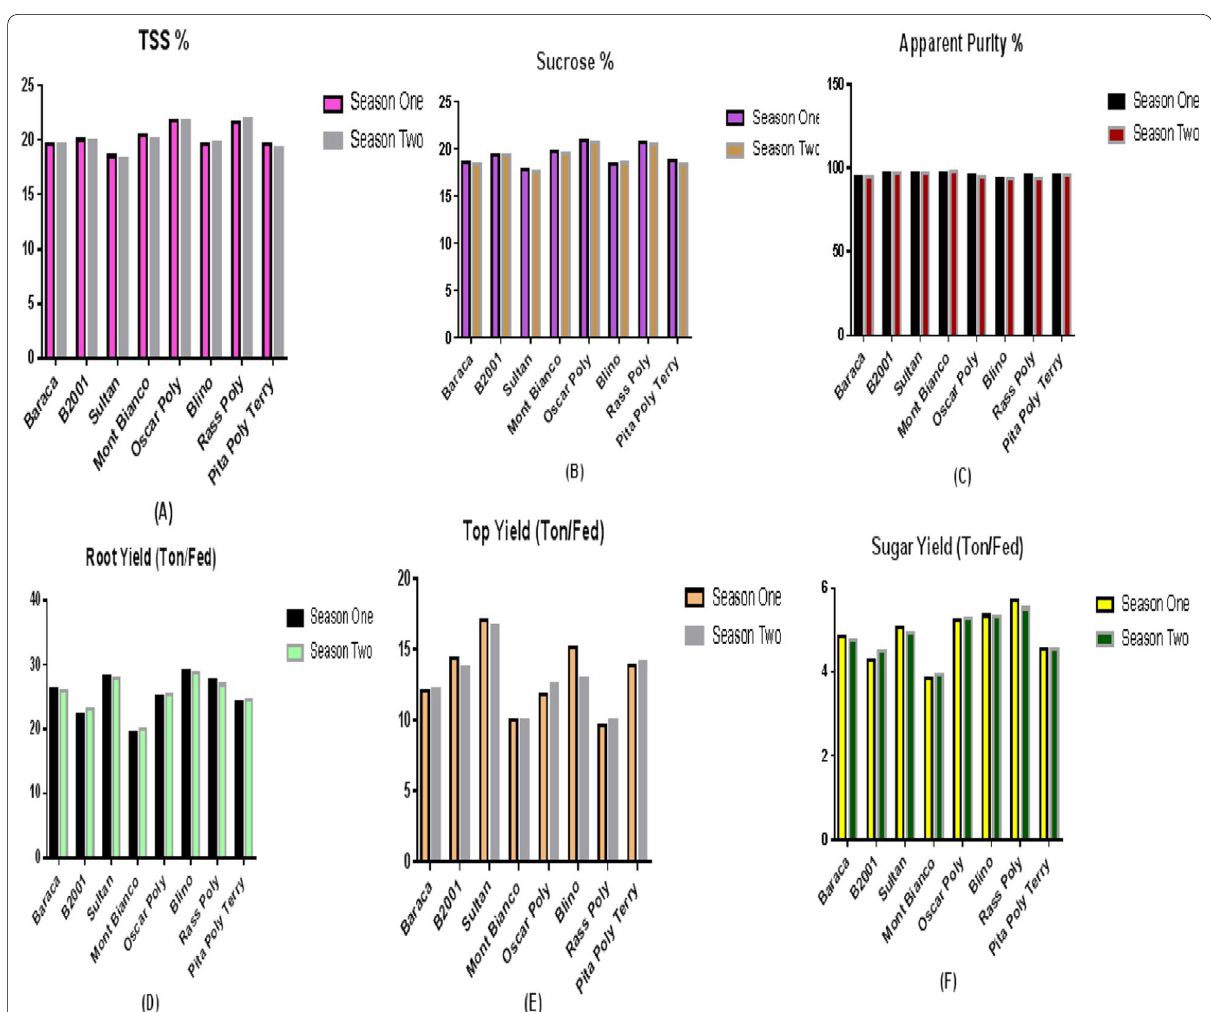
Fig. 2 Comparison among all studied traits for the eight Beta vulgaris accessions within two growing seasons including the forms; A, B, C, D, E and F using Graph pad prism software Version 7,